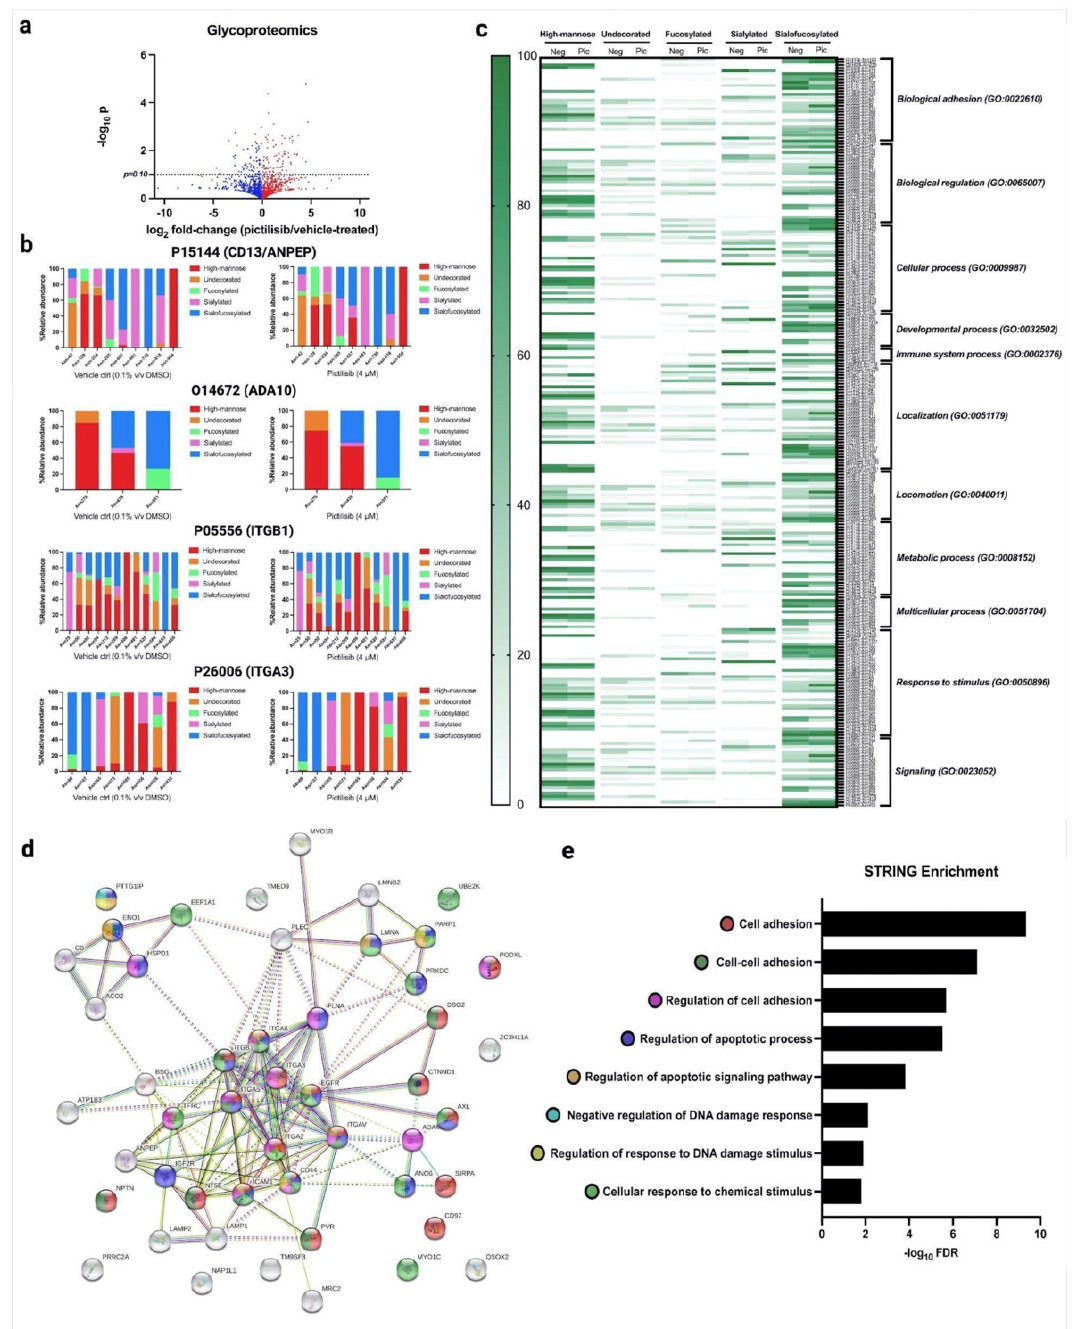
Figure 4. Pictilisib treatment reduced sialylation and fucosylation in specific glycoproteins. ( a ) Volcano plot of differentially abundant glycopeptides; ( b ) Site-specific glycosylation—high-mannose, undecorated, fucosylated, sialylated, and sialofucosylated—of several glycoproteins shown to have reduced fucosylation, sialylation, or sialofucosylation following pictilisib treatment; ( c ) Gene ontology analysis of proteins with reduced fucosylation, sialylation, and fucosylation shows glycoproteins involved in several biological processes; ( d ) STRING interaction analysis shows the interaction of the glycoproteins with reduced fucosylation, sialylation, or sialofucosylation; ( e ) Subsequent STRING enrichment analysis shows a significant enrichment of biological processes involved in adhesion, apoptosis, response to chemicals, and DNA damage. The data represent mean ± SD; n = 3. The statistical differences were detected utilizing multiple t -test with FDR